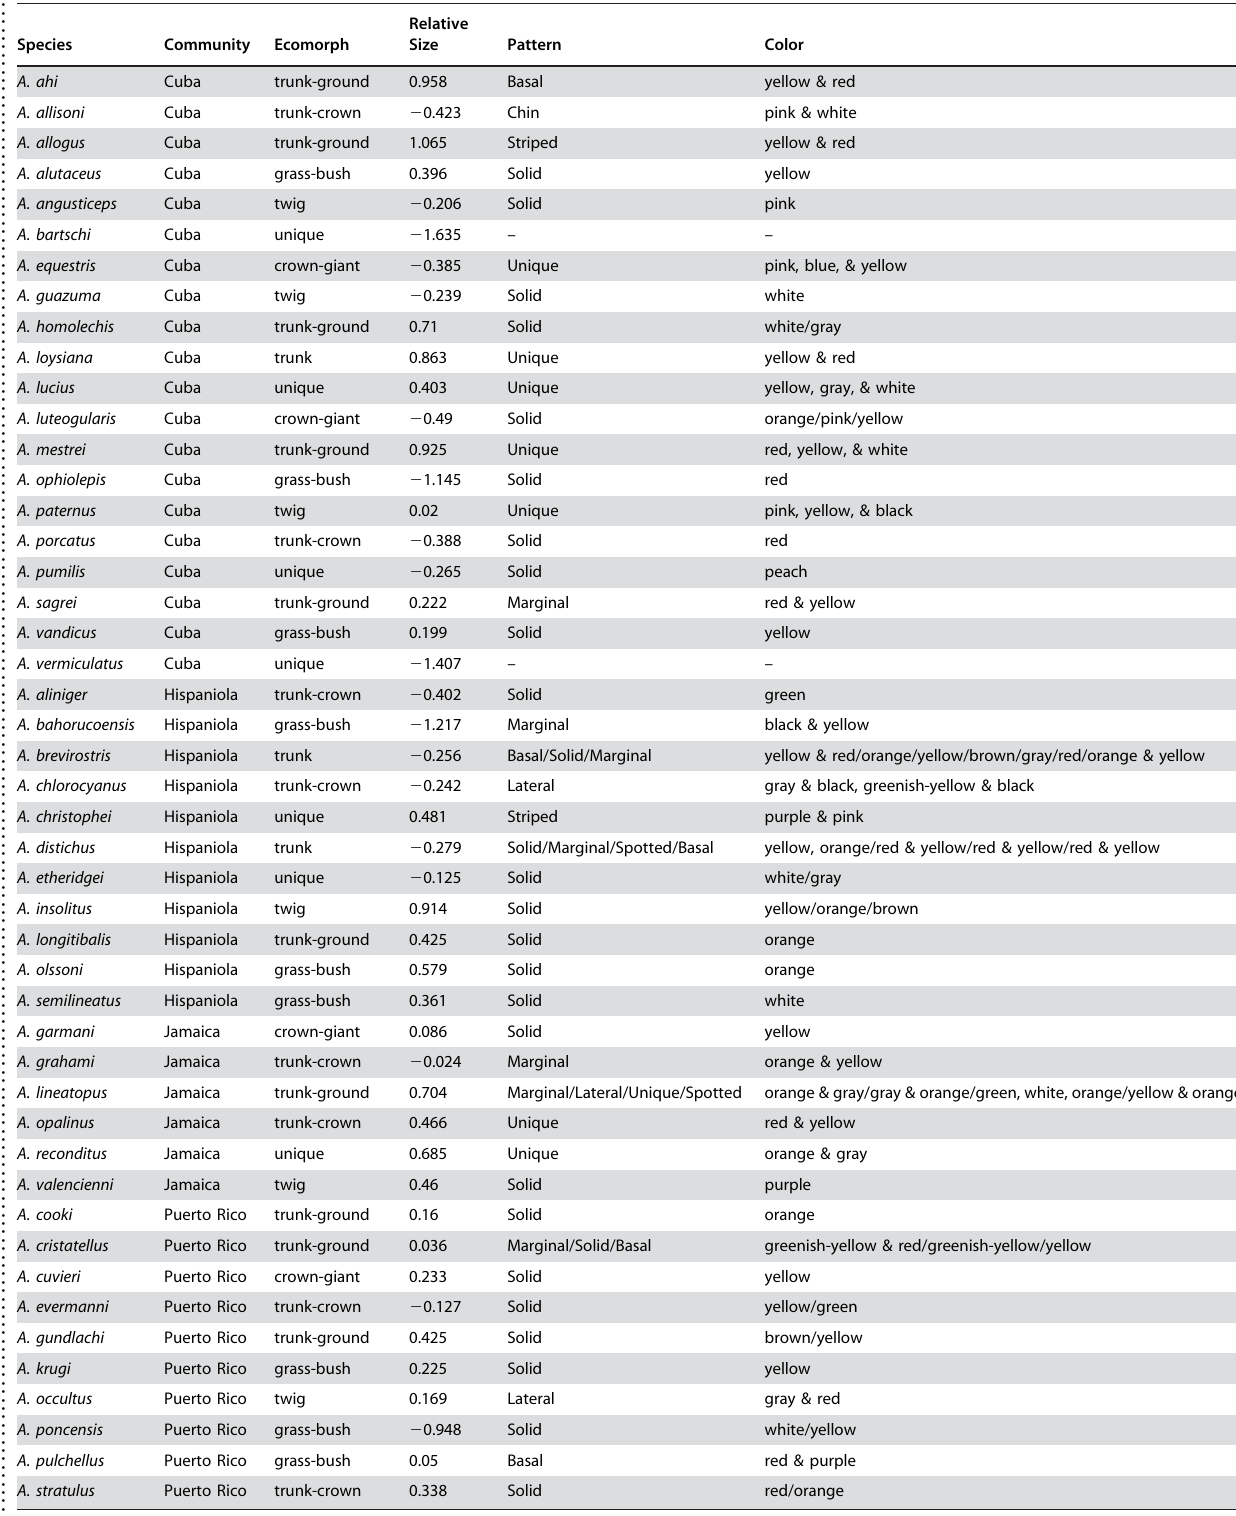
Table 4. Data used to test the Ecomorph Convergence hypothesis. .. ... .... ... ... .... ... ... .... ... ... .... ... ... .... ... ... .... ... ... .... ... ... .... ... ... .... ... ... .... ... ... .... ... ... .... ... ... .... ... ... .... ... ...